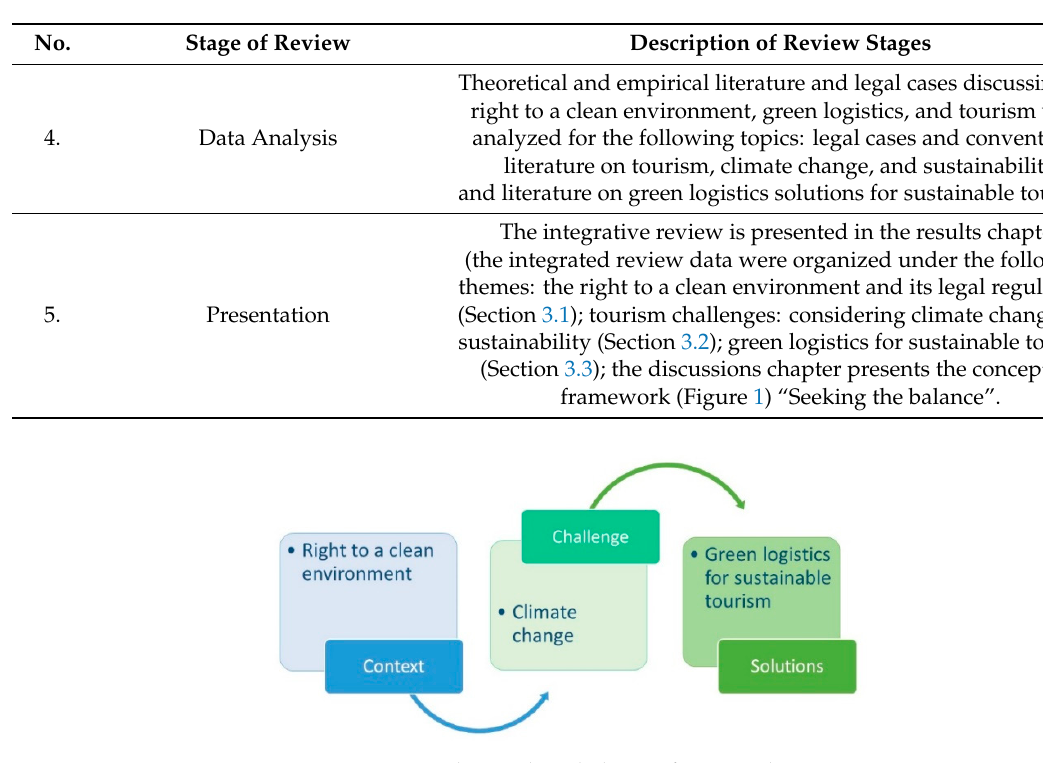
Figure 1. The “seeking balance” framework.